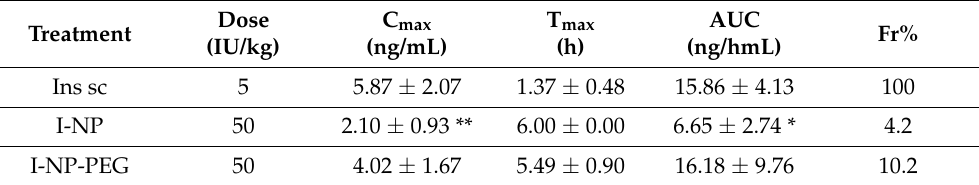
Table 3. Pharmacokinetic parameters of insulin administered either subcutaneously or orally. Ins sc: subcutaneous insulin (5 IU/kg); I-NP: insulin-loaded bare nanoparticles (50 IU/kg); I-NP-PEG: insulin-loaded PEG-coated nanoparticles (50 IU/kg); C max : maximum plasma concentration;